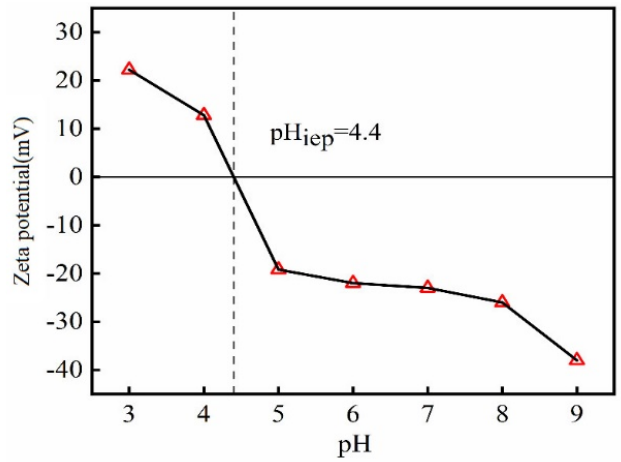
Figure 2. Zeta potential of carbon black analyzed at different pH values.